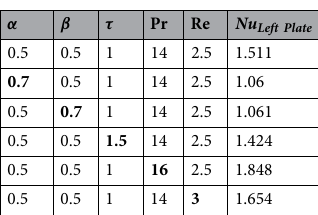
Table 3. Nusselt number variation against different parameters.